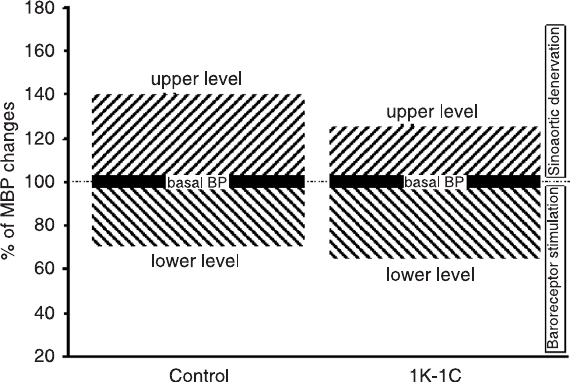
Figure 2. Schematic representation of the range of baroreceptor control of blood pressure (% of MBP changes) using data from Figure 1. The upper level was obtained from a conscious rat in response to sinoaortic denervation and the lower level from an anesthetized rat by electrical stimulation of the aortic nerve. Left, normotensive control rat; right, chronic 1-kidney/1-clip renal hy- pertensive (1K-1C)